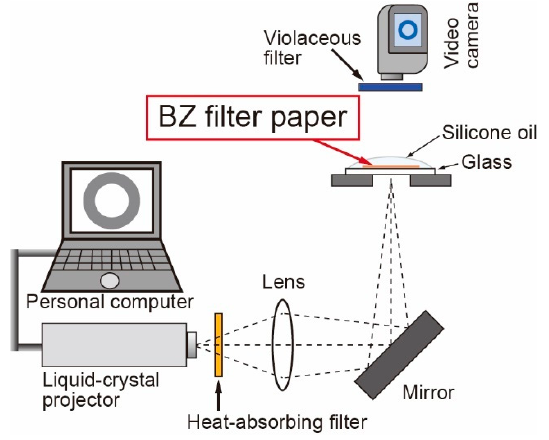
Figure 1. Schematic illustration of the experimental setup. A filter paper was soaked in the Belousov–Zhabotinsky (BZ) solution for one minute and placed on a glass plate, which is indicated as “BZ filter paper”.